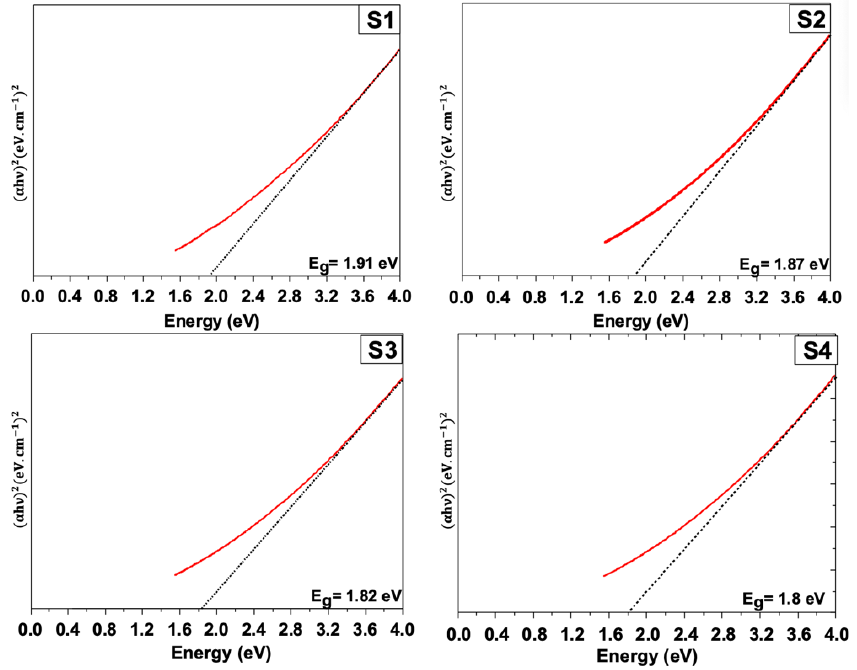
Figure 11. Tauc plots for all samples showing the lowest band-gap energy value for the sample S4.